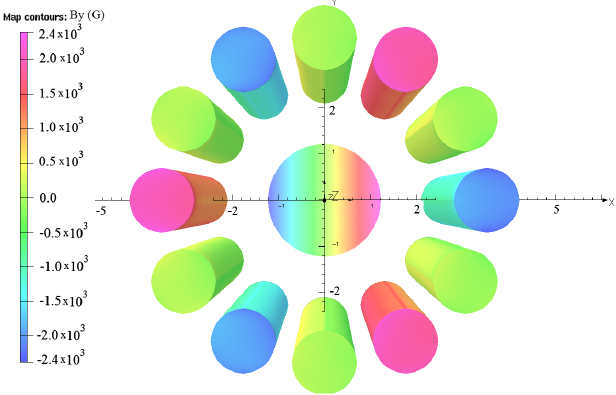
FIG. 7. Arrangement of 12 PMs and the field in the good field radius at the center of the magnet ( Z ¼ 0 ).